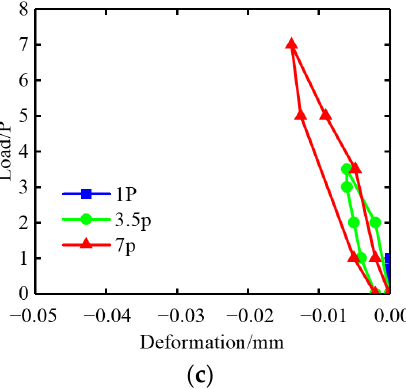
Figure 17. Test results of dislocation gauge: ( a ) back anchor surface; ( b ) middle anchor; ( c ) front anchor.